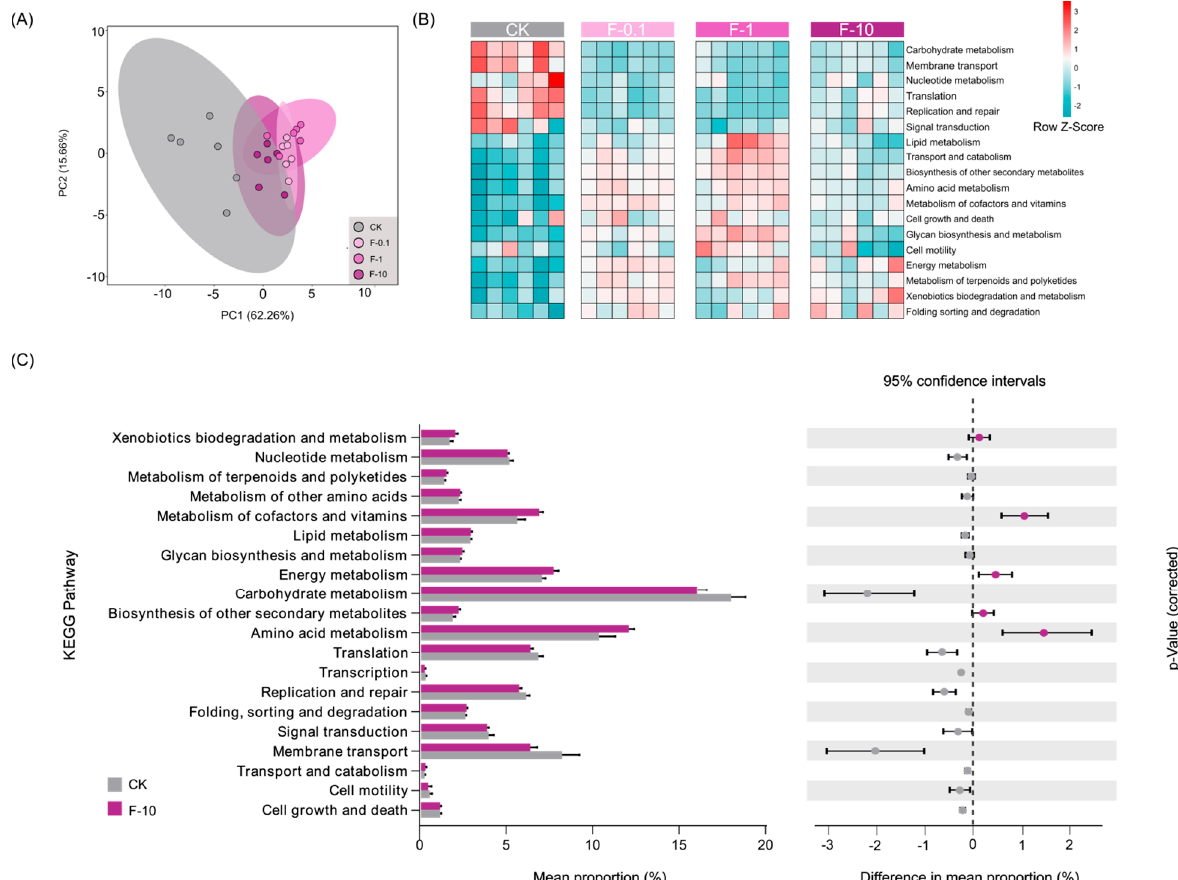
Figure 6. Functional profiles of the gut microbiota are distinguishable between CK and flupyradifurone-treated bumblebees. ( A ) PCA plot describing functional inferences (PICRUSt) of bacterial communities across flupyradifurone treatments. ( B ) Heatmap displaying the differentially enriched KEGG pathways (Level 2) prediction by PICRUSt across different concentration treatment groups. ( C ) Bar plots showing the relative abundance of KEGG pathways prediction by PICRUSt and the difference between CK and F-10.